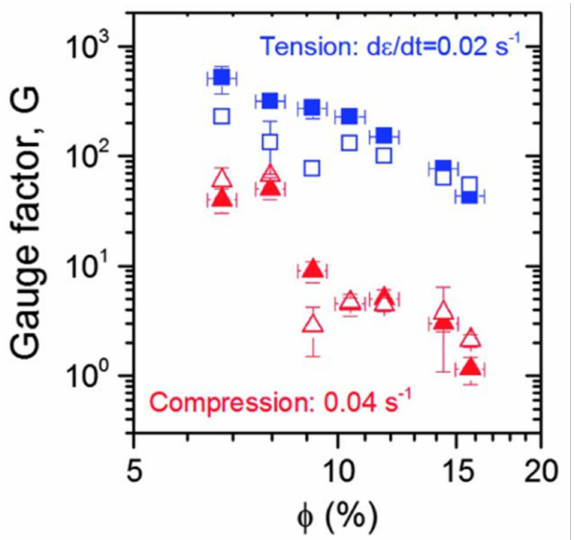
Figure 8. Gauge factor (G) plotted versus volume fraction ( ∅ ) for both tensile (blue) and compressive (red) measurements. The solid symbols represent measured values, and the open symbols represent predicted values [71]. Reproduced with